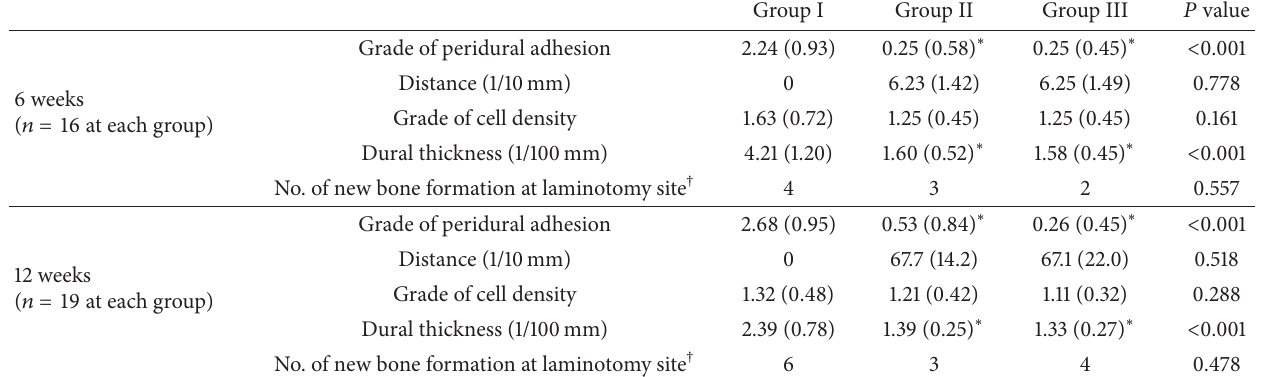
Table 1: Histological